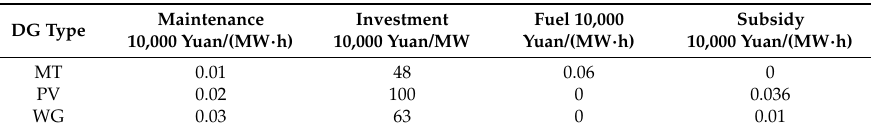
Table 2. DG cost.